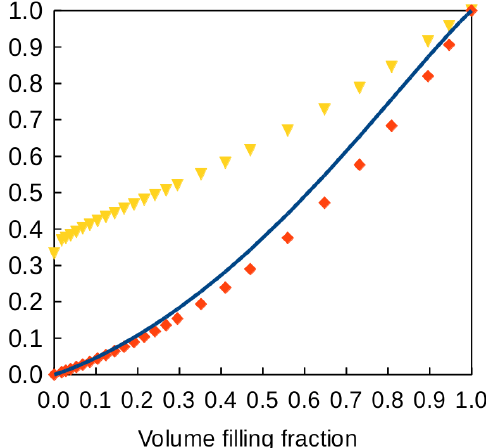
Figure 3. Thermal properties of the Dul’nev lattice versus filling fraction when the conductivity of air is neglected. Blue curve: relative conductivity κ e / κ m predicted by Equation (6); red diamond: results of full numerical calculations; yellow triangles: thermal conductivity efficiency χ from the full numerical